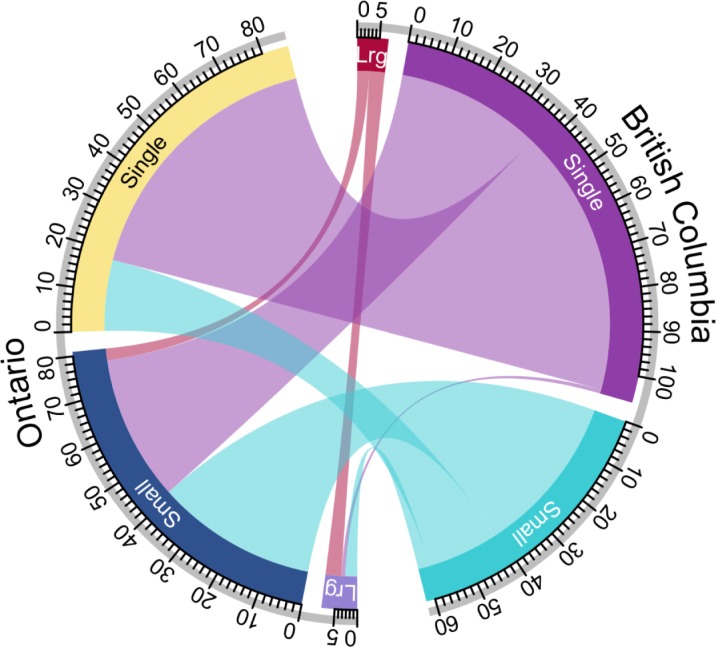
Interprovincial genotype matches by cluster size within a province.A circular chord diagram visualizing the number (indicated by tick marks) of interprovincial 24-locus MIRU-VNTR genotype matches between Ontario (left) and British Columbia (right) from 2008–2014, grouped by the number of isolates within each province sharing the matched genotype: single (1 isolate), small (2–9 isolates), large (≥10 isolates). Flow width indicates the number of genotypes. For example 20 single isolates each with a different MIRU-VNTR pattern in Ontario are genotype matches to 20 different small British Columbia MIRU-VNTR clusters.